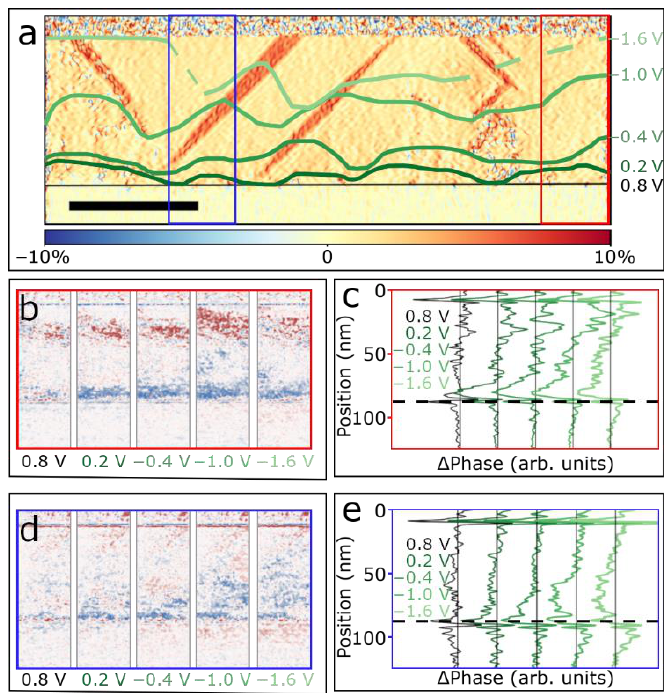
Figure 5. ( a ) In-plane ε xx strain map with an overlay of the estimated position of the switching front throughout the experiment. The red and blue rectangles correspond to the regions shown in ( b , d ), respectively. The scale bar is 50 nm. ( b , d ) Slices of the phase change plots at different voltages, showing the progression of the switching front in a predominantly defect free region ( b ) and a region enclosing a ferroelastic needle-like domain ( d ). ( c , e ) Line profiles of the average phase change extracted along horizontal direction in the regions shown in ( b , d ), respectively.